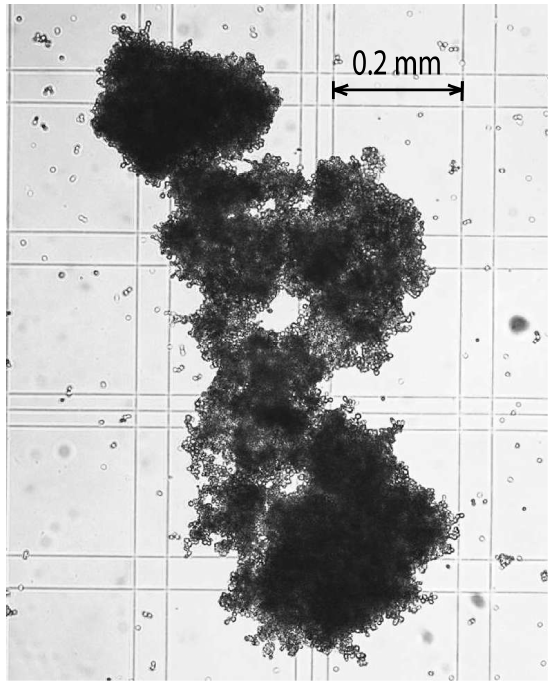
Figure 2 . A flock of yeast on a counting chamber under observation by microscope with 50X magnification.